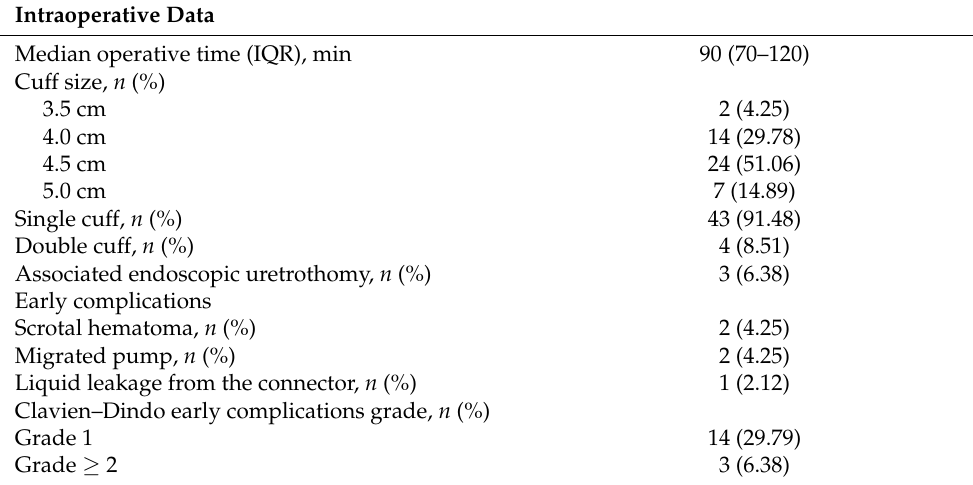
Table 2. Intraoperative and early complications